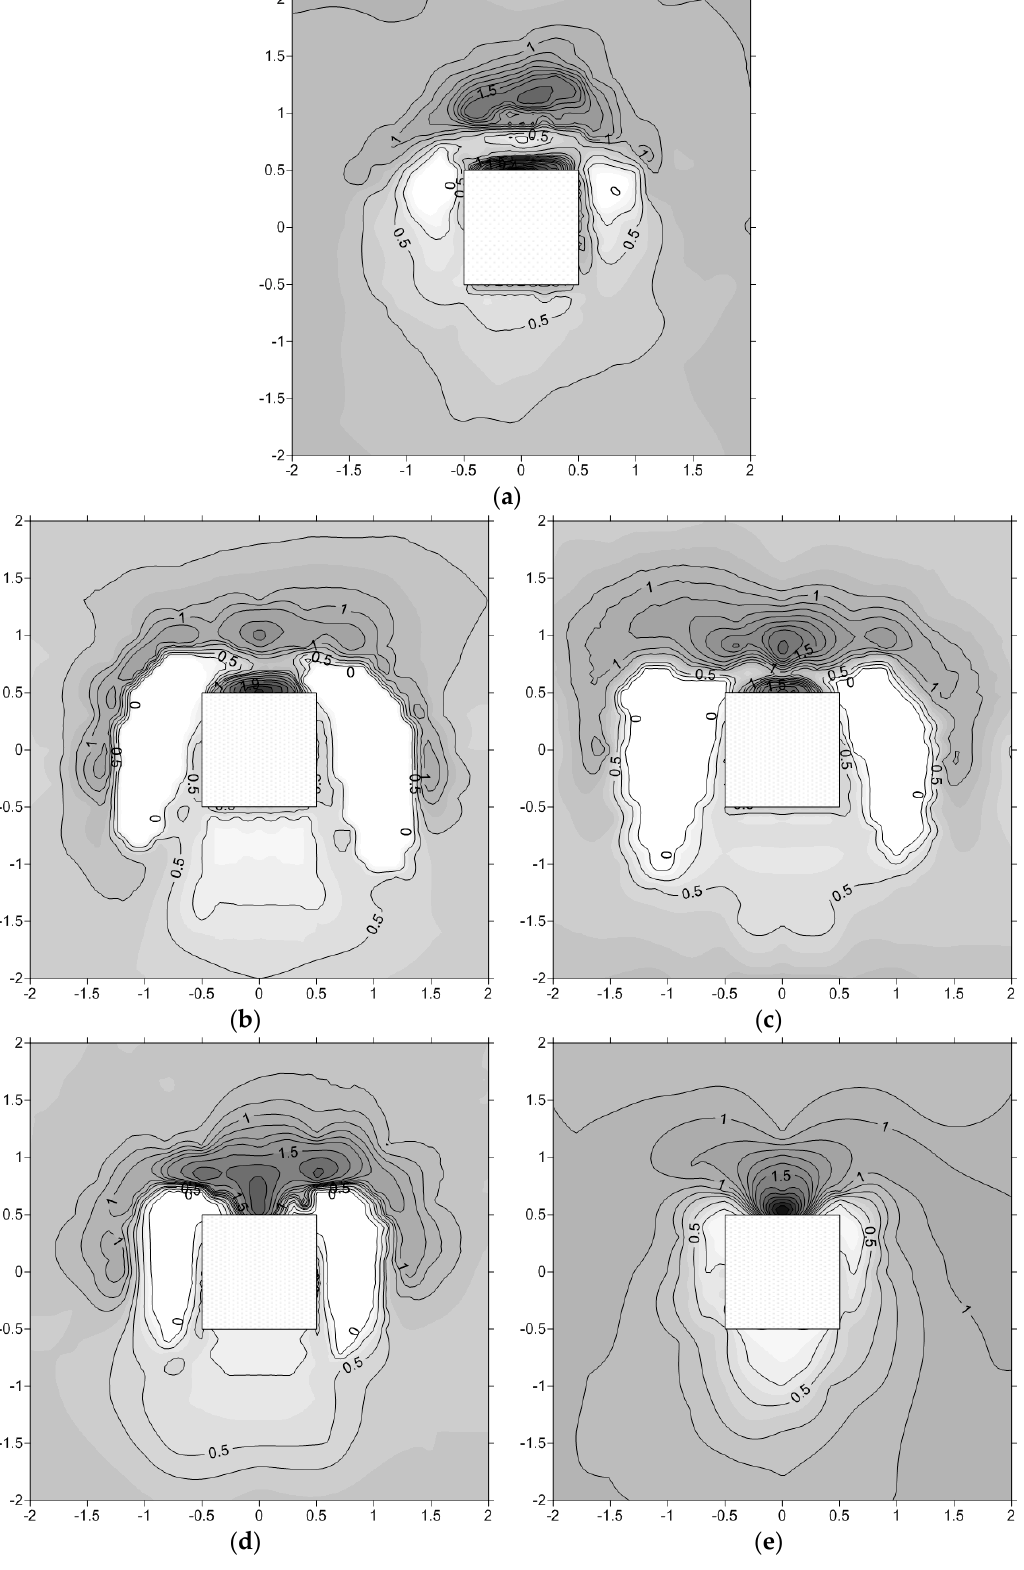
Figure 12. Contour maps of the snowdrift geometry around the model: ( a ) field observation; ( b ) experiment with a 1 m Cube model; ( c ) experiment with a 0.5 m Cube model; ( d ) experiment with a 0.25 m Cube model; and ( e ) experiment with a 0.1 m Cube model.